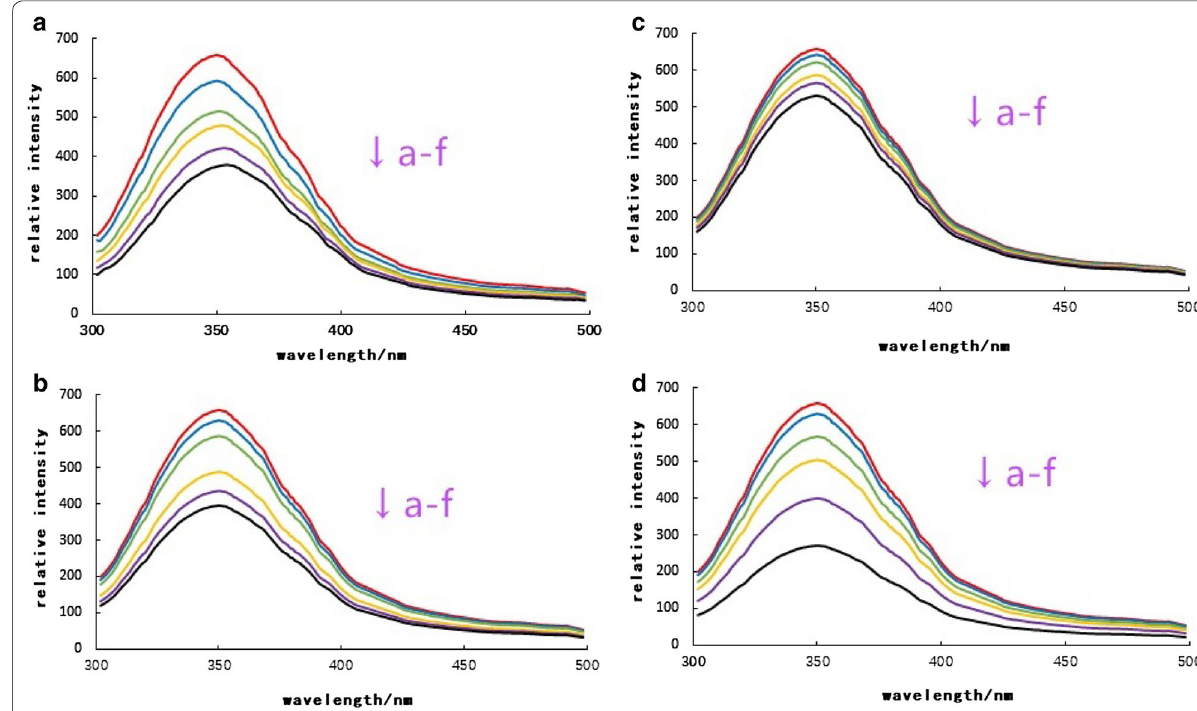
Fig. 1 Fluorescence emission spectra of BSA suspension at excitation wavelength 280 nm in presence of 0, 5, 10, 20, 30, 40 μmol/L (a–f) Cyanidin-3- O -arabinoside ( a ), Cyanidin-3- O -galactoside ( b ), Cyanidin-3- O -glucoside ( c ) and Cyanidin-3- O -Xyloside ( d